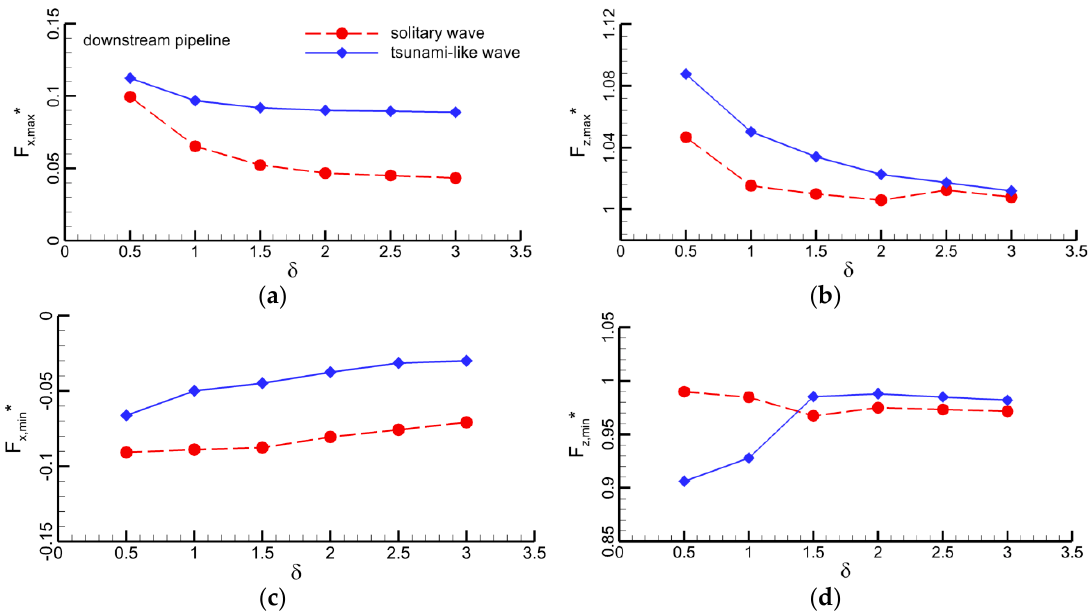
Figure 31. Horizontal and vertical forces on the upstream pipeline as function of spacing ratio; ( a ) maximum horizontal force F x,max *; ( b ) maximum vertical force F z,max *; ( c ) minimum horizontal force F x,min *; ( d ) minimum vertical force F z,min *.